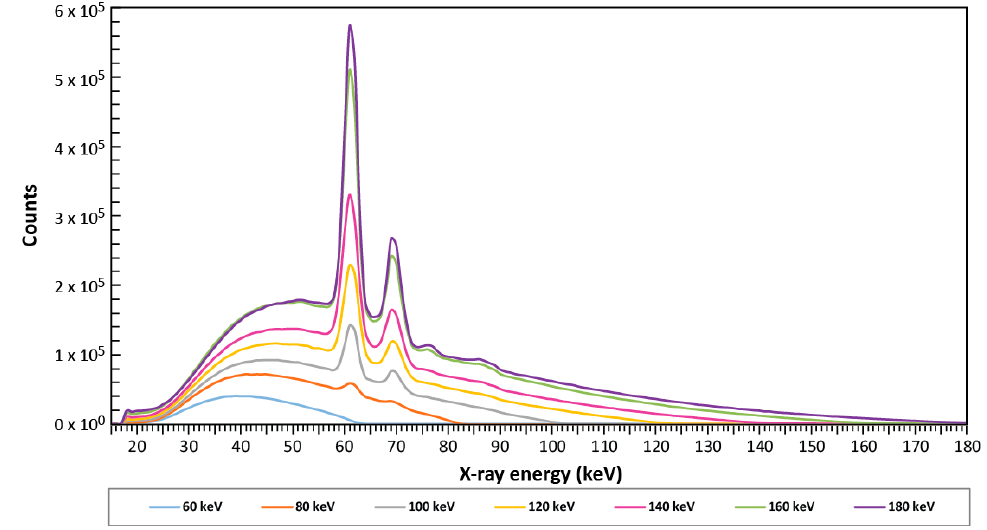
Figure 1. Different tungsten energy spectrums collected at different X-energies [20]. Figure 1. Di ff erent tungsten energy spectrums collected at di ff erent X-energies